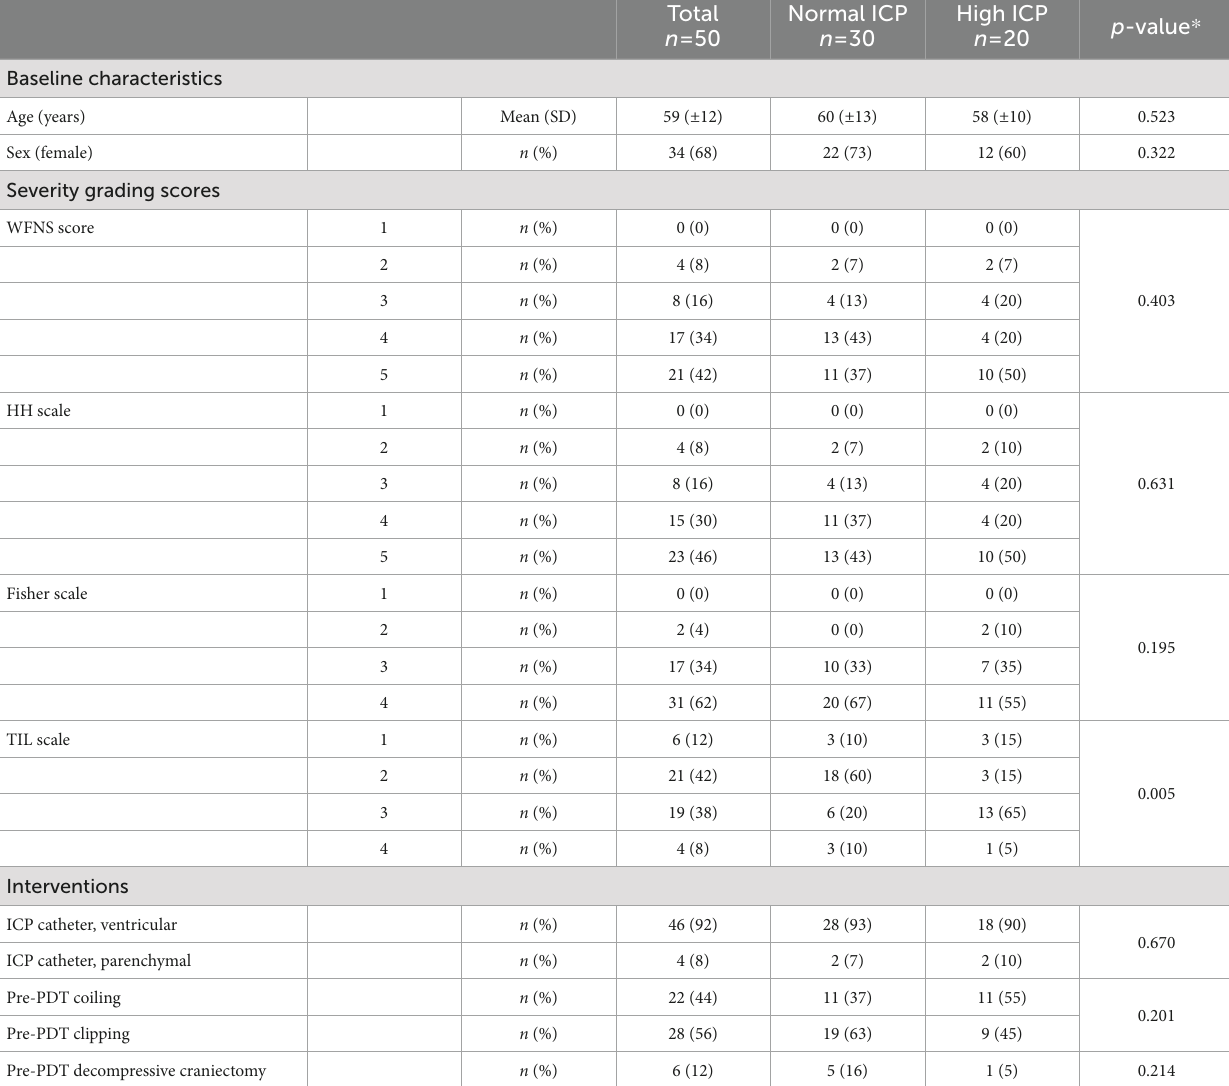
TABLE 1 Baseline patients’ characteristics, neurological injury severity, and associated interventions in the overall population of adult patients with SAH adult admitted during the study period after aneurysm control through clipping or coiling ( n =